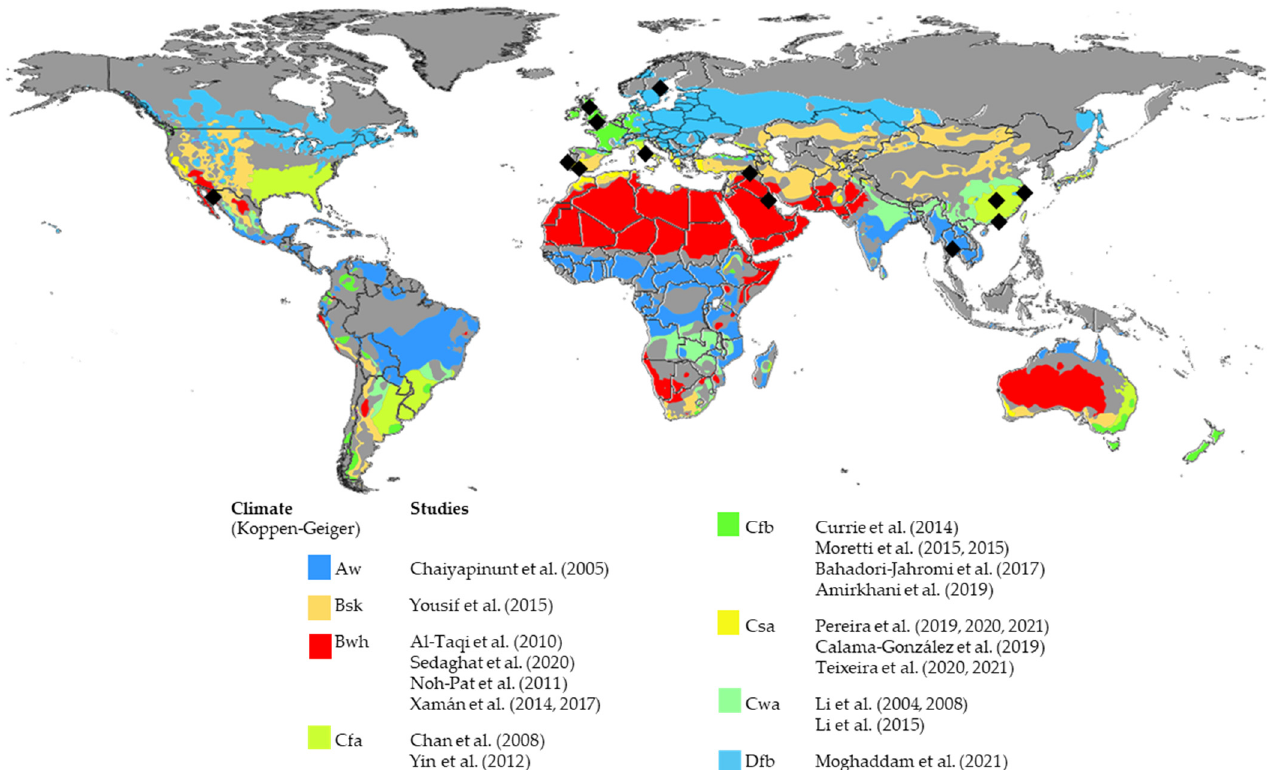
Figure 9. Location of the case studies [19,35–57] of the existing research works regarding the performance of solar control films installed in building glazing and identification of the respective climate type in accordance with the Köppen–Geiger climate classification [58].